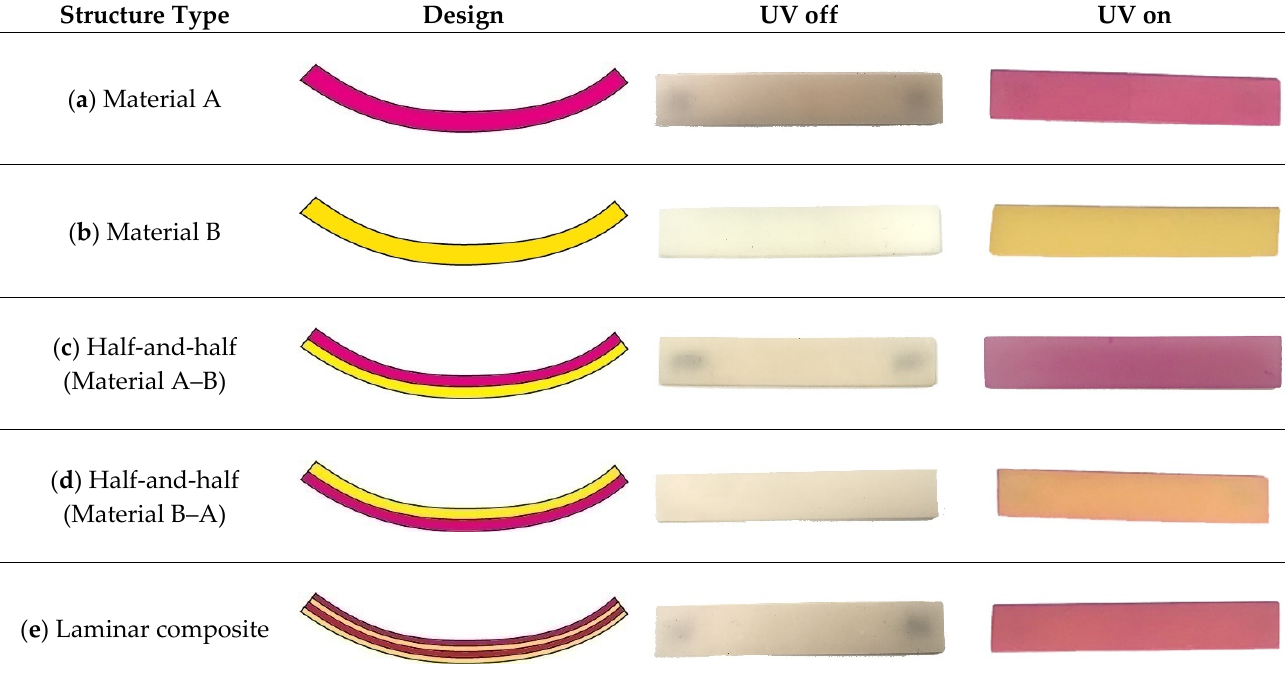
Figure 10. Specimens in the 3-point bending test.